Question: Write a single sentence explaining what this figure depicts.
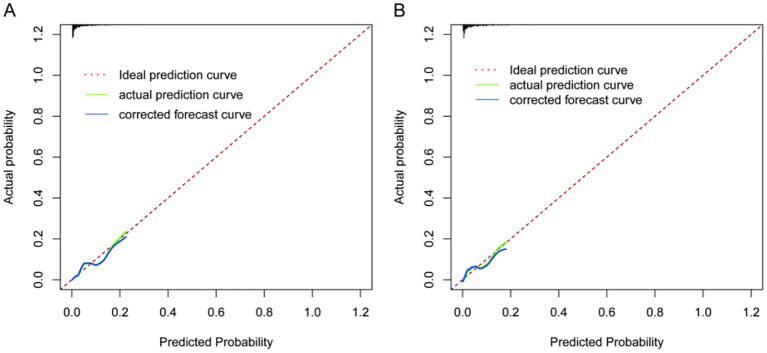
Answer: Calibration curve. (A) Train; (B) Test.